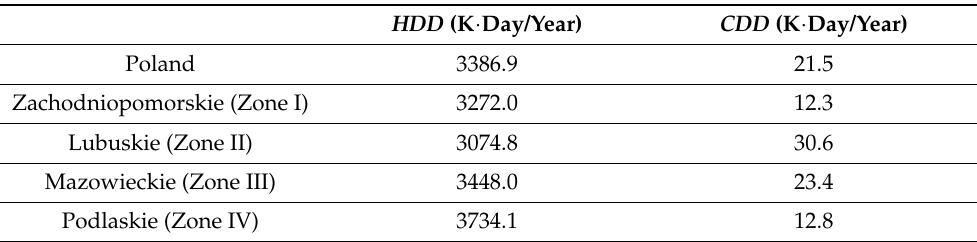
Table 1. Average values of degree days of the heating and cooling period for the whole of Poland and selected regions in Poland.